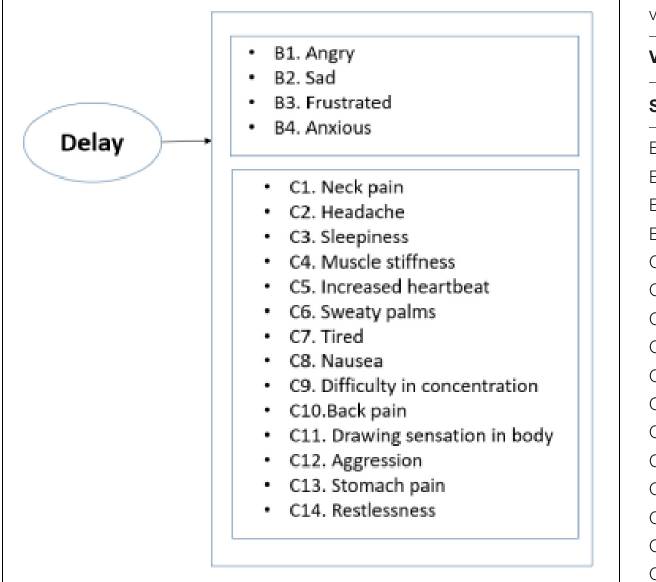
FIGURE 1 | Summary of main predictors in the instrument.